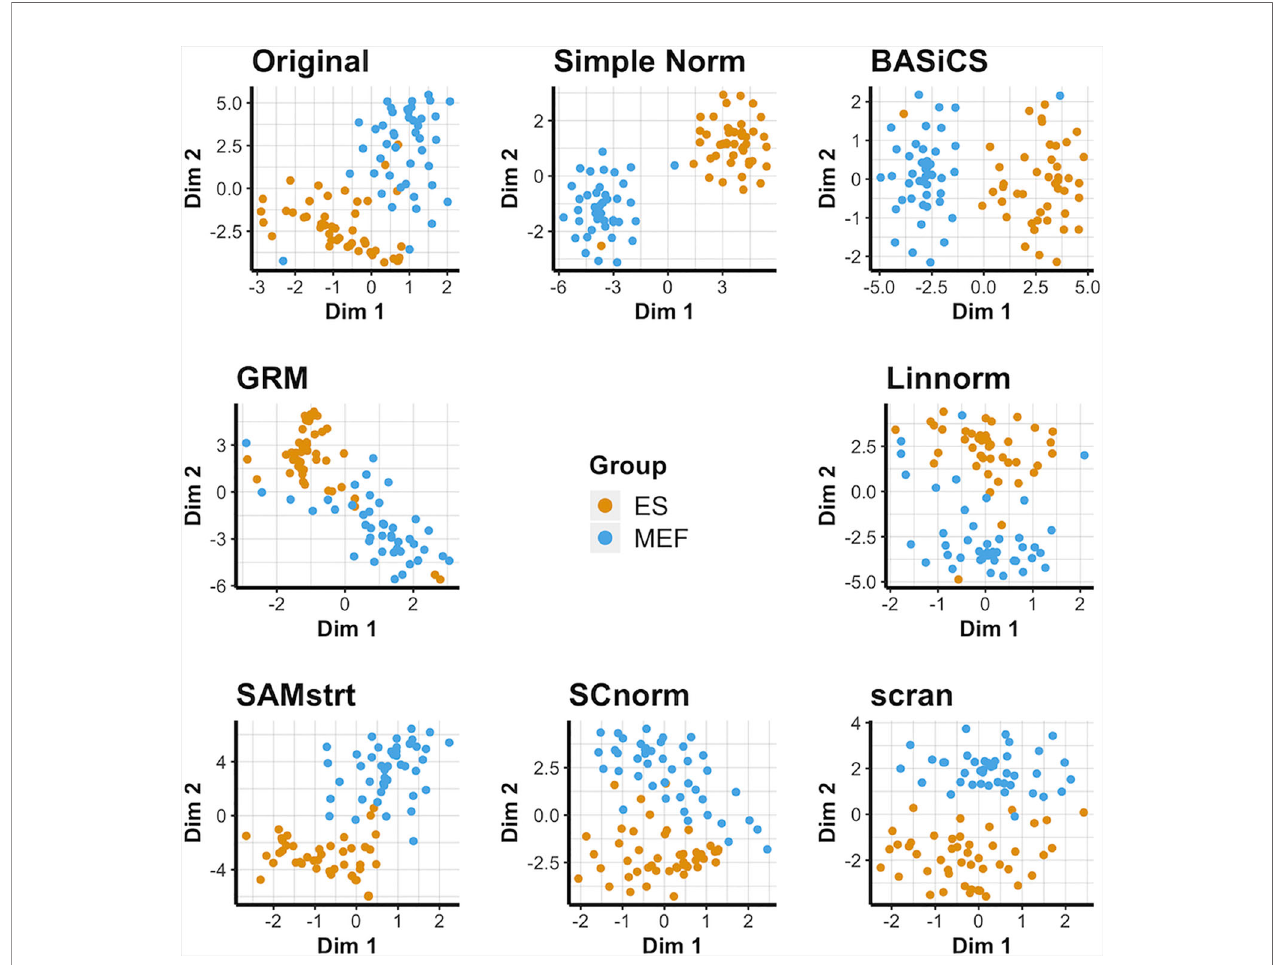
FIGURE 1 | t-SNE plots of the mouse embryonic data set under various normalization methods, with the original data for